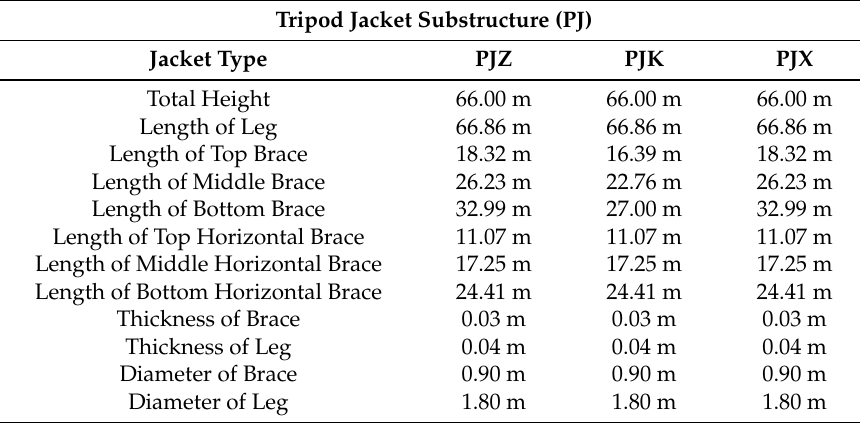
Figure A6. Terminology of the structural members of a PJ-structure. Table A3. Specification of three PJ-structures.